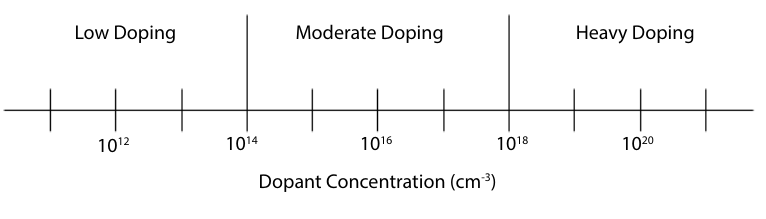
Figure 3. Dopant concentration levels.